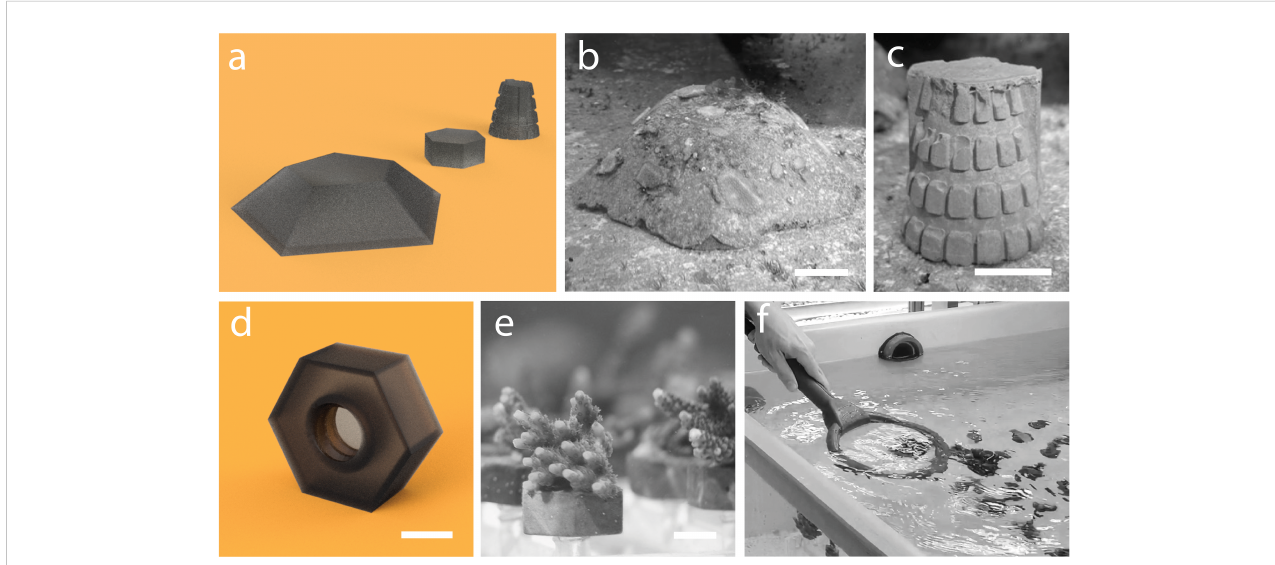
FIGURE 1 Maritechture ™ Screwable coral tiles (patent pending, U.S. Patent Application No. 17/767,251Filed April 7, 2022). (A) Different shapes to cater to different propagation pathways. (B) Microframentation tile. (C) Recruitment tile. (D) Fragment tile. (E) Coral tiles attached to the coral crate. (F) Trackable tiles are RFID microchipped and can be identi fi ed using a conventional chip reader, which can be operated underwater. White bar indicates 1 cm in width.